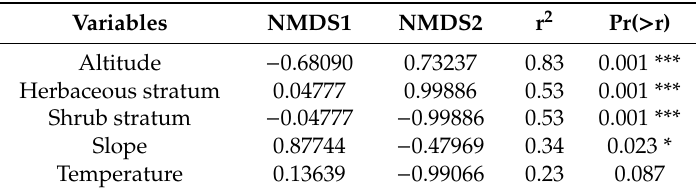
Figure 3. Boxplot of some structural and richness characteristics in each altitudinal gradient. Hereby ( A ) represents the Shanon index; ( B ) the herbaceous stratum; ( C ) the shrub stratum; and ( D ) total species.